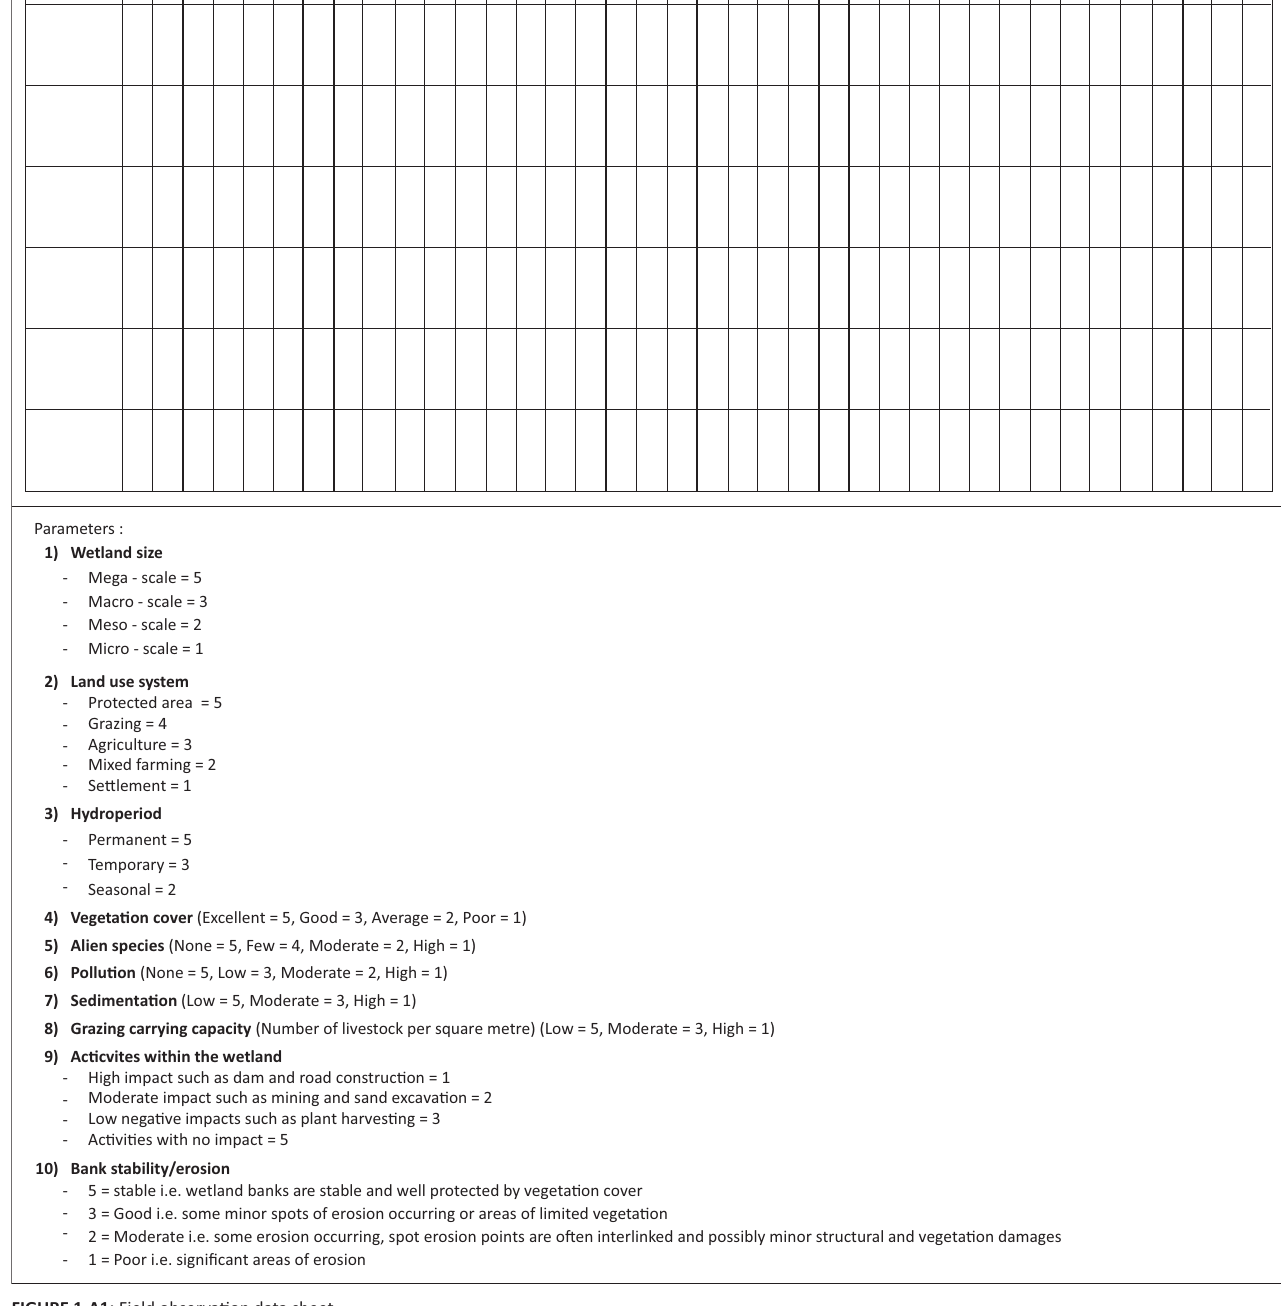
FIGURE 1-A1: Field observation data